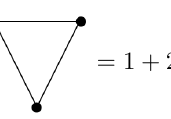
FIG. 14. Weights in the calculation of Tr ρ 3 denotes one of three elementary transpositions in the permutation group S 3 . Two lines denote any distinct pair of